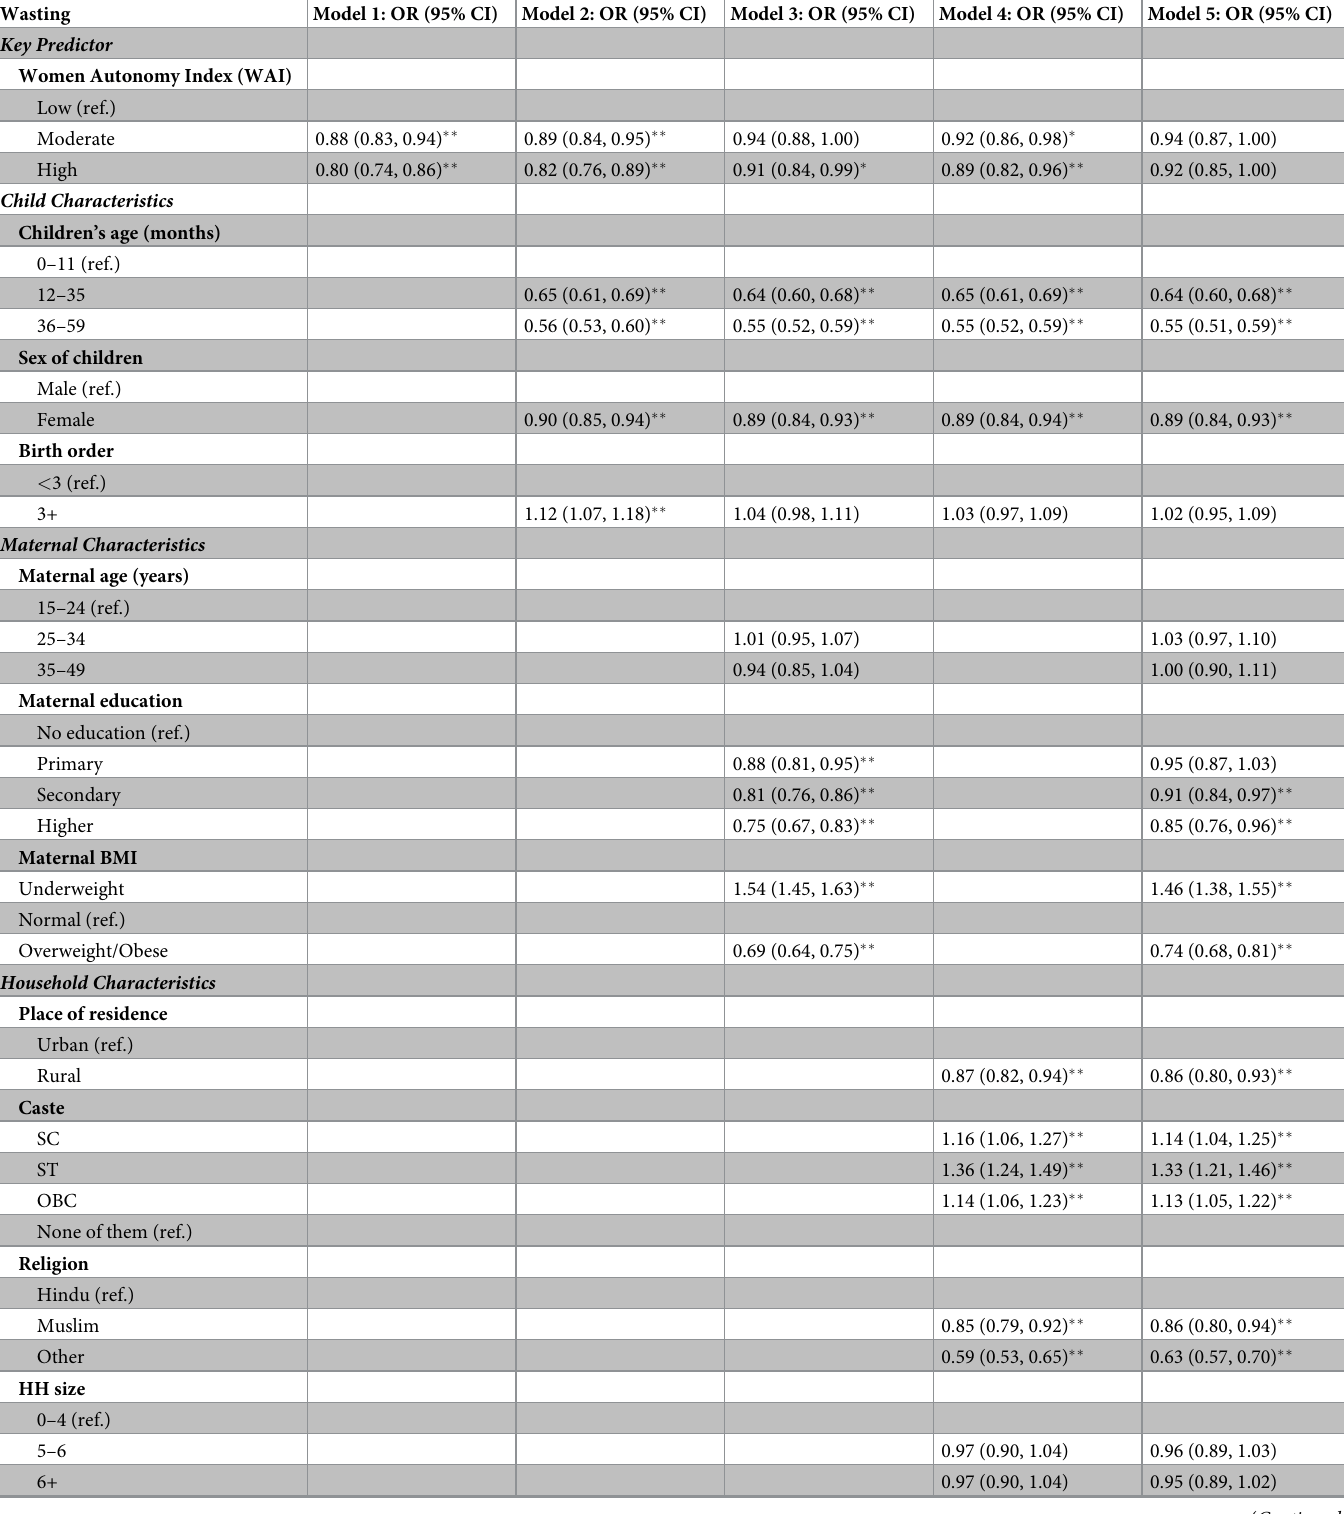
Table 4. Binary logistic regression models assessing the association between maternal autonomy and wasting among under-five children, NFHS-4 (2015–16).